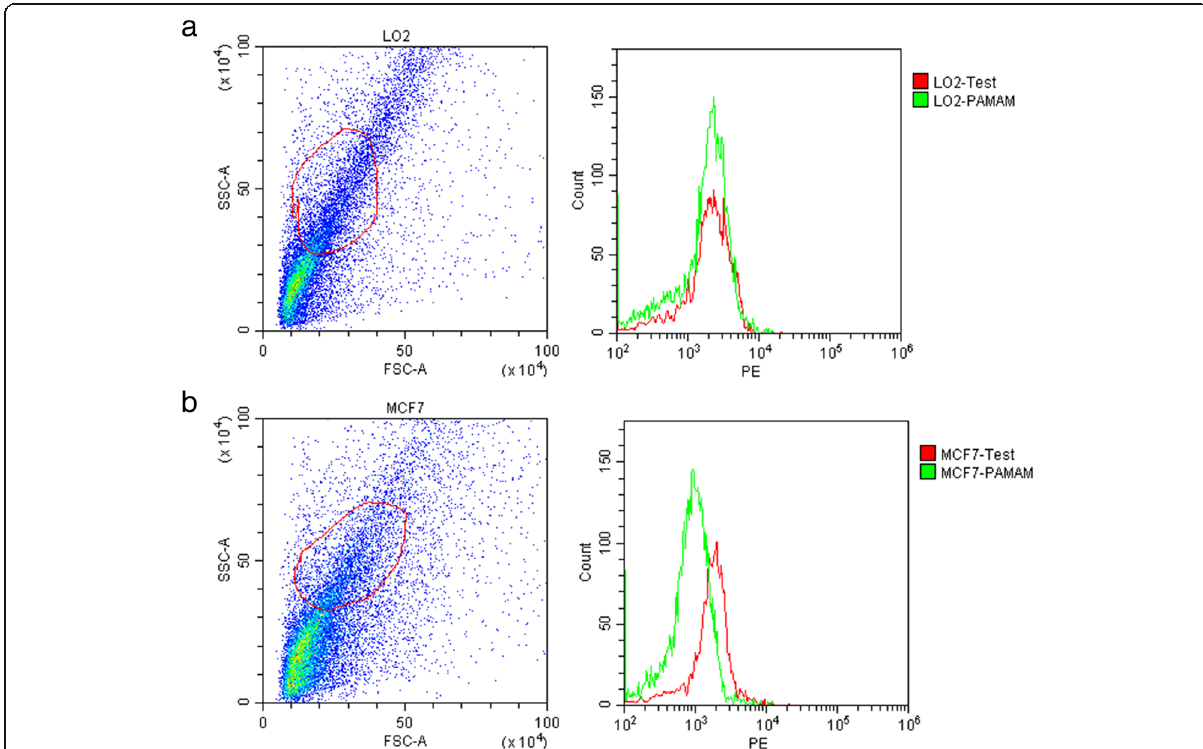
Fig. 4 Fluorescence analysis of HSP27 by flow cytometry. a L02 cells. b MCF-7 cells. The test group was incubated with N-PAMAM-IgG and QDs- IgG, PAMAM group as the control, which was only incubated with N-PAMAM-IgG to form a pseudocell for micromolecule protein detected by FCM. When the two curves almost overlap, it can be determined that there is no HSP27 in the sample; therefore, whether QDs-IgG is added or not, the fluorescence intensity will not